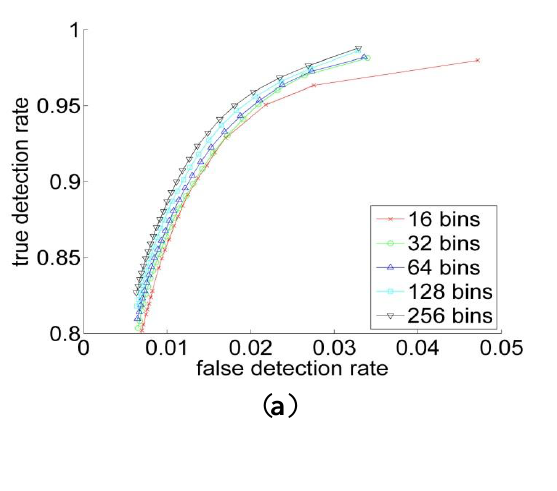
Figure 6. The ROC curve of ( a ) RGB; ( b ) YCbCr; ( c ) HSV and ( d ) L*a*b* spaces for the different histogram